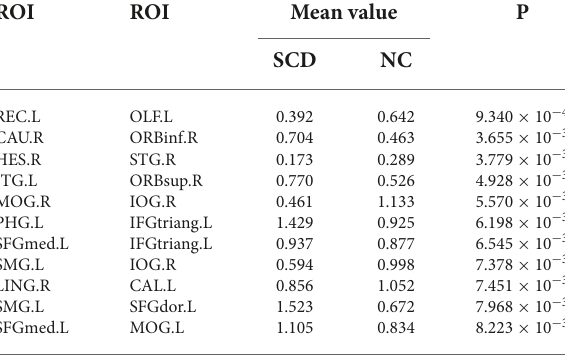
TABLE 4 Consensus connections in the NC and SCD groups. ROI ROI Mean value P SCD NC REC.L OLF.L